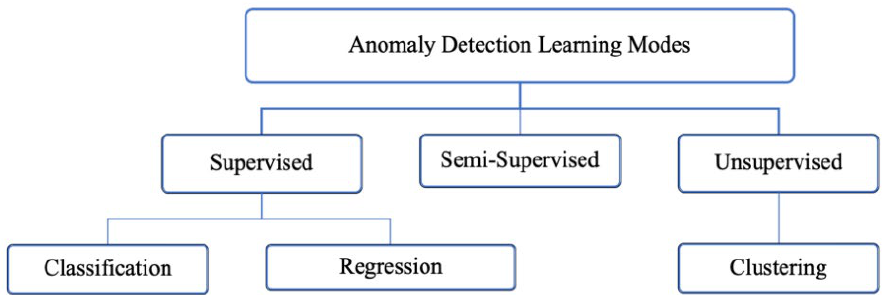
Figure 6. IoT anomaly detection learning modes.